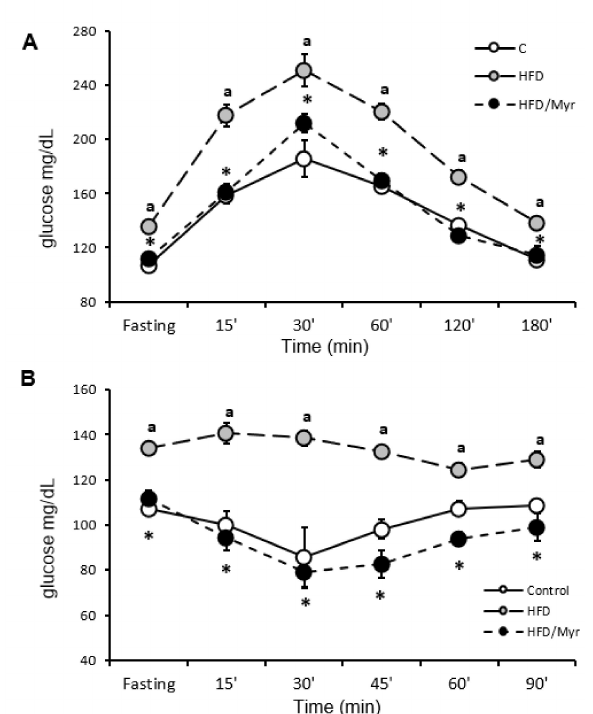
Figure 1. Myriocin treatment improved glucose and insulin tolerance in animals on a high-fat diet. Panel ( A ) shows blood glucose profiles obtained during oral glucose tolerance test (OGTT); Panel ( B ) shows blood glucose profiles during intraperitoneal insulin tolerance test. Values are mean +/ − SD. Symbols denote statistical significance of p < 0.05 against: a —vs. control group; *—vs. HFD group. Table 1. Metabolic parameters in rats with HFD-induced insulin resistance and under myriocin (Myr) treatment.